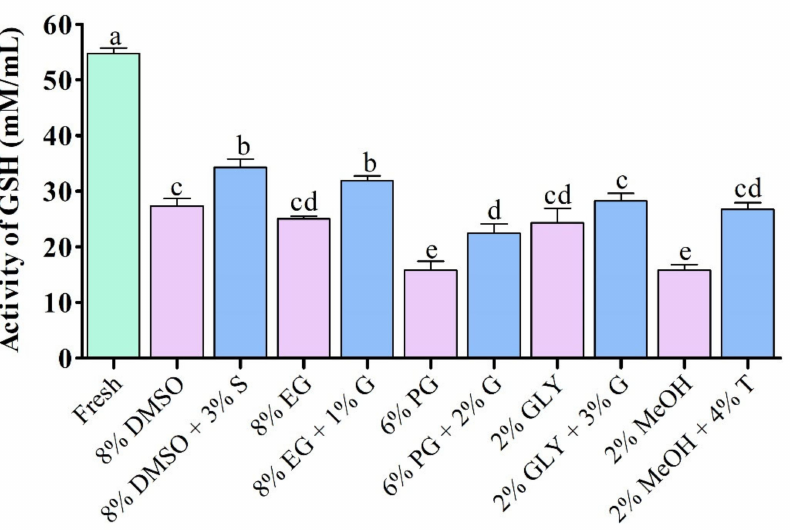
Figure 7. Enzymatic activities of glutathione (GSH) in different types of post-thaw sperm cryopre- served using saccharides. DMSO: dimethyl sulfoxide, EG: ethylene glycol, PG: propylene glycol, GLY: glycerol, MeOH: methanol, S: sucrose, G: glucose, T: trehalose. Results are presented as mean values ± standard deviation ( n = 10). Significantly different levels ( p < 0.05) are denoted by differ- ent letters.